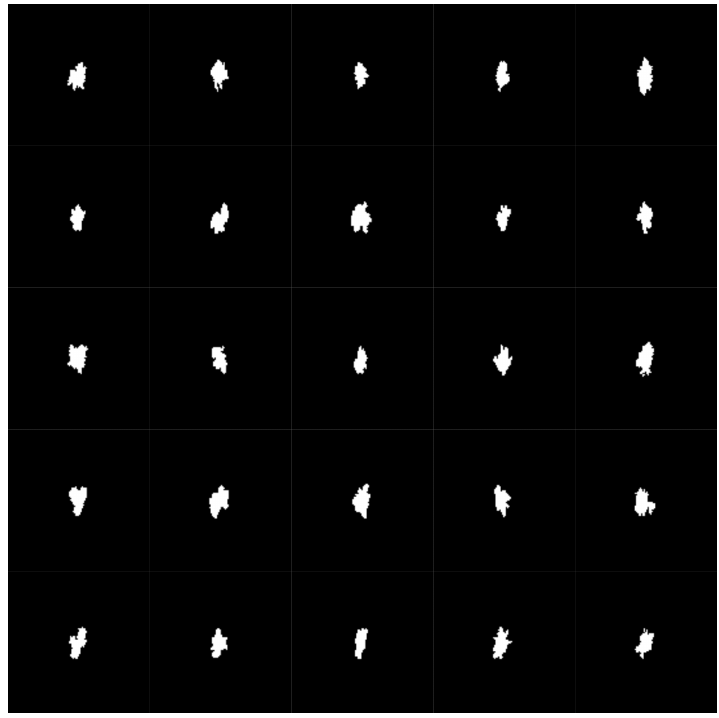
Figure A4. Images identified as RAs by participants and unidentified by the algorithm. The algorithm gave all these images a high score in both RA and